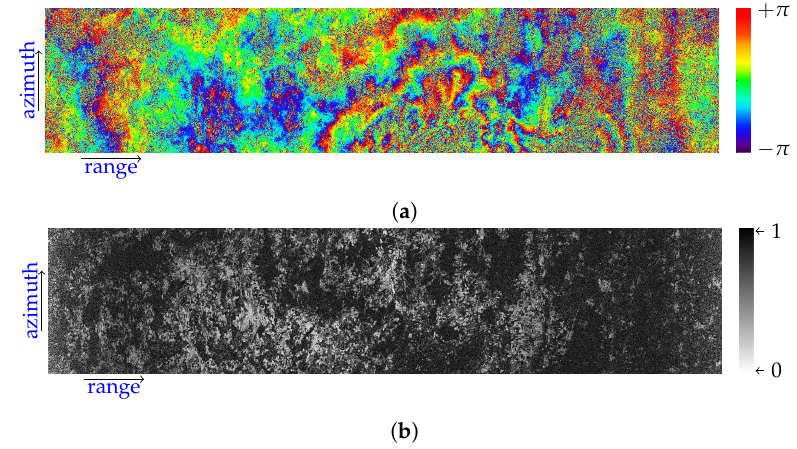
Figure 12. Burst interferogram ( a ) and the corresponding coherence ( b ) computed from the pair, focused through the presented approach, relevant to the S1B raw dataset acquired on August 23rd 2018 and the S1A raw dataset acquired six days later, over the DLR calibration site, shown in Figure